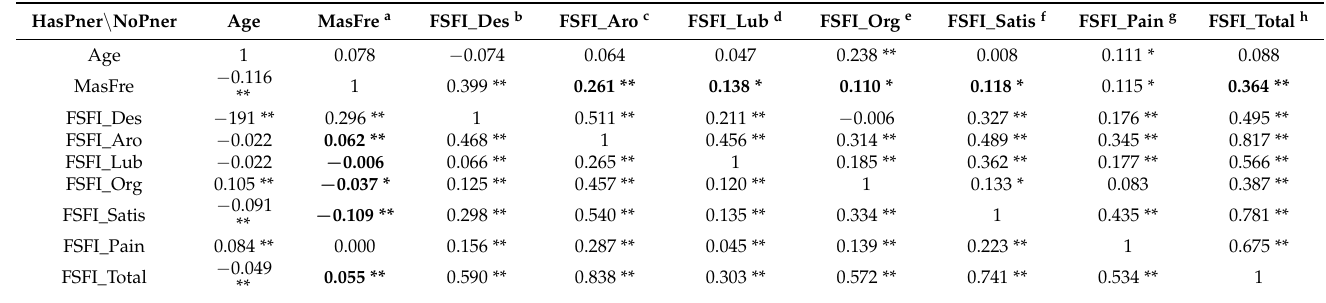
Table 1. Correlations between Age, Masturbation Frequency, FSFI_Desire, FSFI_Arousal, FSFI_Lubrication, FSFI_Orgasm, FSFI_Satisfaction, FSFI_Pain, and FSFI_Total for women who have a partner (in the below diagonal) and women who do not have a partner (in the above diagonal).